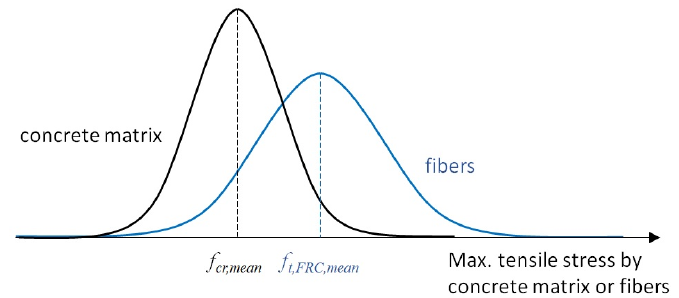
Figure 7. Normal distribution of the tensile stress due to steel fibers.